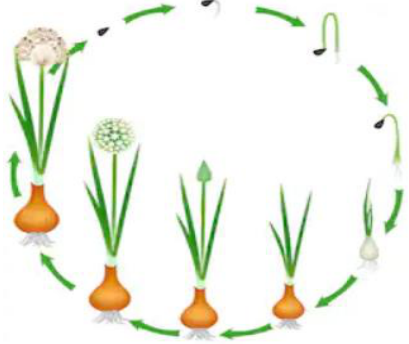
Figure 1. Onion growing states in the cultivation process.